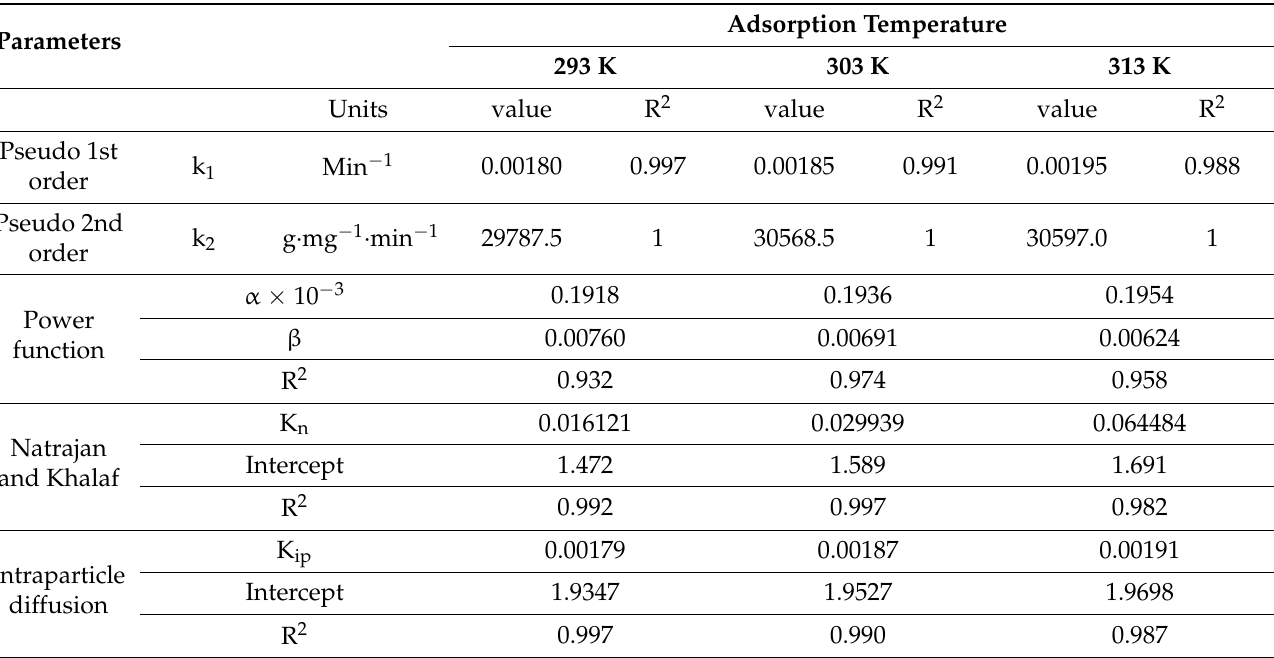
Table 3. Kinetics parameters for the adsorption of Basic Red 5 dye on the